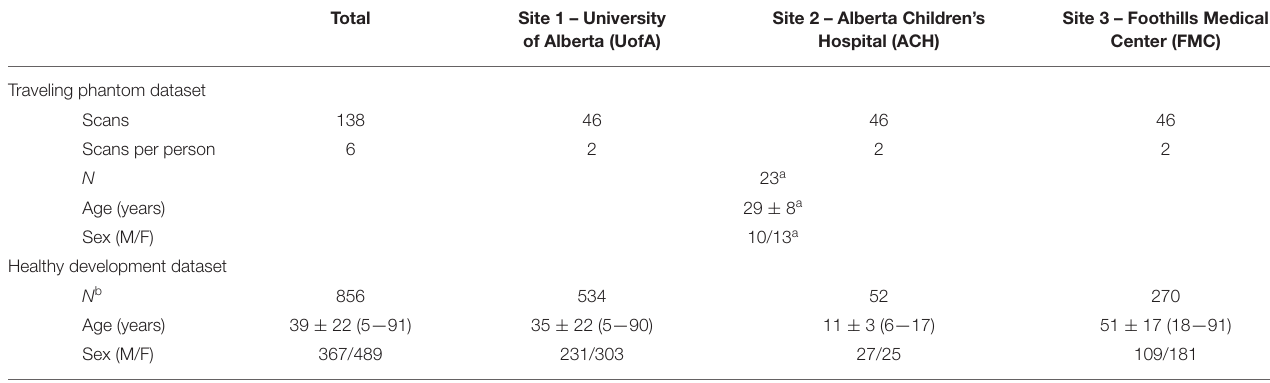
TABLE 1 | Participant demographics.